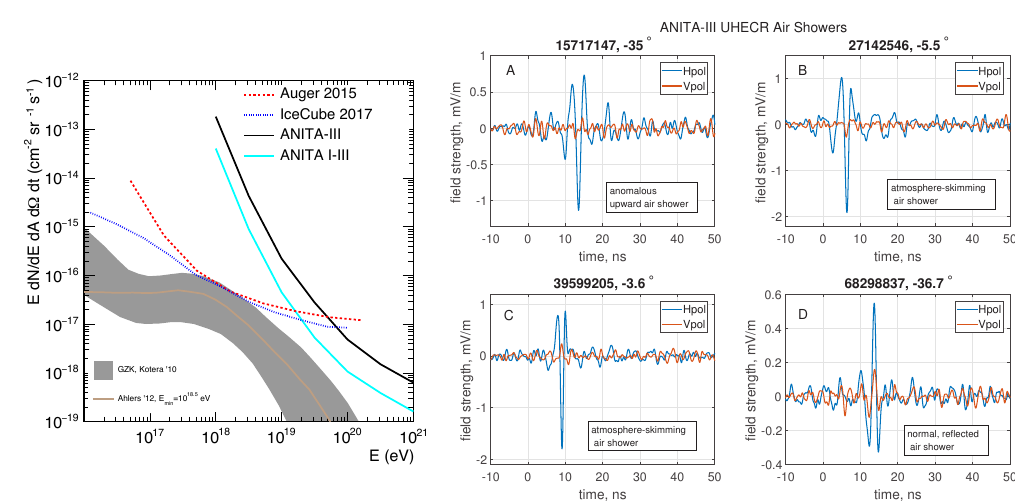
Figure 2. Left: The ANITA-III limit on the all-flavor di ff use ultra-high-energy neutrino flux and a combined limit from ANITA-I-III, using the ANITA-III limit shown here and the published ANITA-I and ANITA-II limits [5, 6]. Figure 1. Left: The 26 EAS-like events that come from below the horizon found by any analysis (red), and the Ultra-high-energy neutrino limits from Auger [7] and IceCube [8], as well as two cosmogenic neutrino models [9, single remaining event in the most sensitive of the three Askaryan neutrino searches (blue). Upper Right: The 10] are also shown. From Reference [1]. Right: The non-inverted, upward-going EAS from below the horizon coherently summed and dedispersed waveform for the single remaining event in the Askaryan neutrino signal (Panel A), two non-inverted cosmic-ray EAS events from above the horizon (Panels B and C), and and an example region. Lower Right: The location (with uncertainties) of the event projected onto the continent, as well as the inverted event from a cosmic-ray EAS where the radio emission reflected o ff of the surface of Antarctica (Panel location of ANITA at the time of the event, and the closest known locations of human activity shown. From D). From Reference Reference [1].